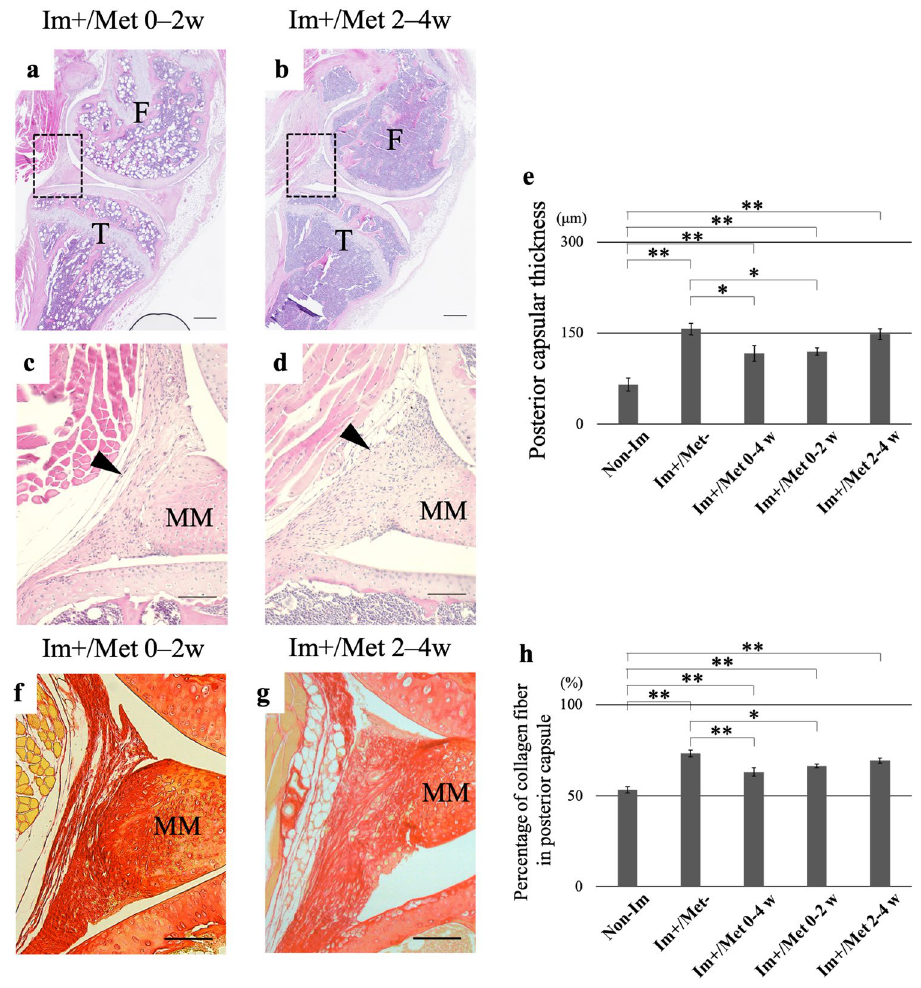
Figure 5. Histological analysis for the effective time of metformin administration for joint capsular fibrosis. Hematoxylin and eosin-stained sections of the knee joints in the (Im+/Met 0–2 weeks) group ( a ) and (Im+/ Met 2–4 weeks) group ( b ). Panels ( c , d ) show high magnification images of the dotted boxes in the panels ( a , b ), respectively (Scale bar: 300 μm ( a , b ), 100 μm ( c , d )). The arrowhead indicates the posterior capsule. ( e ) Posterior capsular thickness. Picrosirius red-stained sections of partial posterior joint capsules for each group ( f , g ) (Scale bar: 100 μm). ( h ) Percentage of collagen fiber in the posterior capsule measured as the ratio of the areas stained red by picrosirius red to the total areas of the posterior capsule. Data are expressed as the mean ± standard errors. *p < 0.05, **p < 0.01; n = 8. F femur, T tibia, MM medial meniscus, Non-Im mice with non-immobilized knees, Im+/Met− mice with immobilized knees but no metformin, Im+/Met 0–4 weeks mice with immobilized knees and metformin administered from 0 to 4 weeks, Im+/Met 0–2 weeks mice with immobilized knees and metformin administered from 0 to 2 weeks, Im+/Met 2–4 weeks mice with immobilized knees and metformin administered from 2 to 4